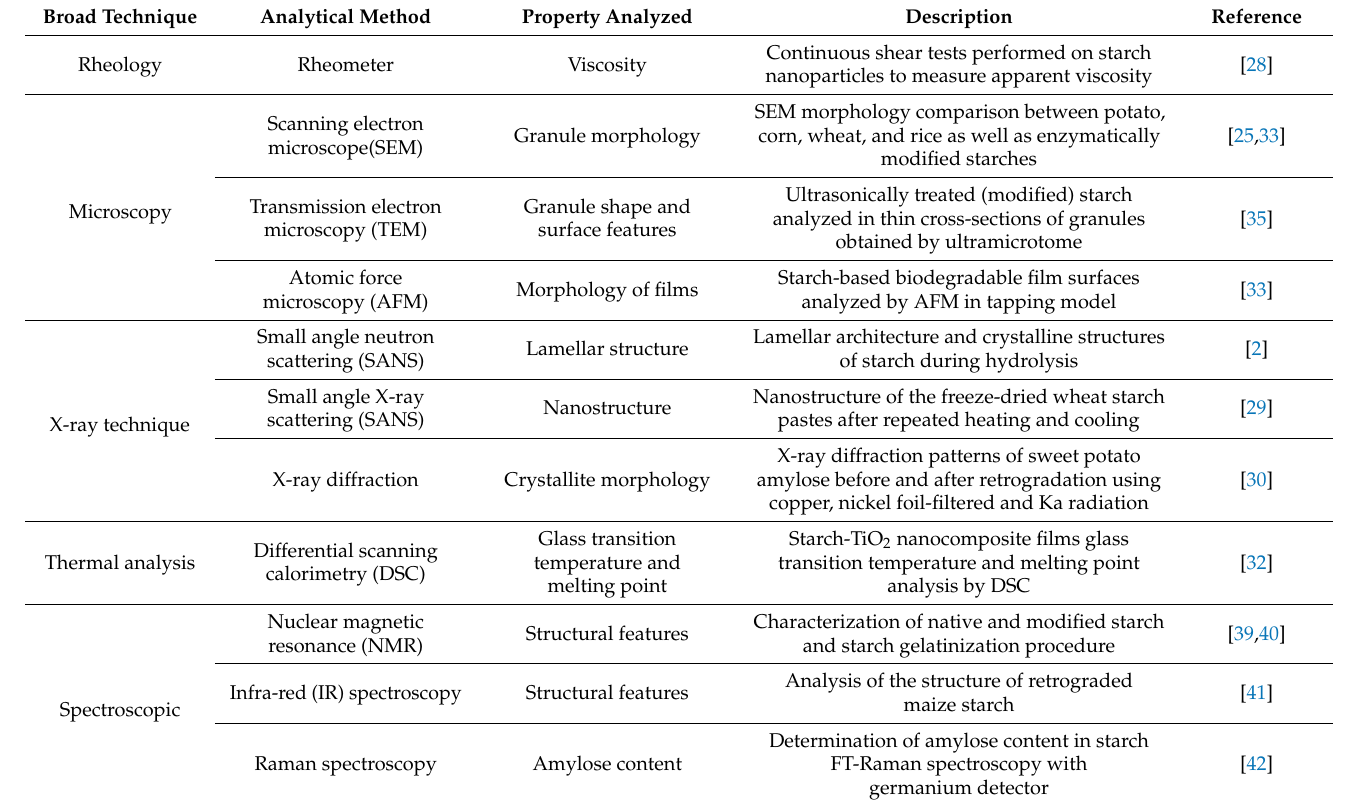
Table 1. Characterization methods for native and modified starch and starch-based biodegrad- able